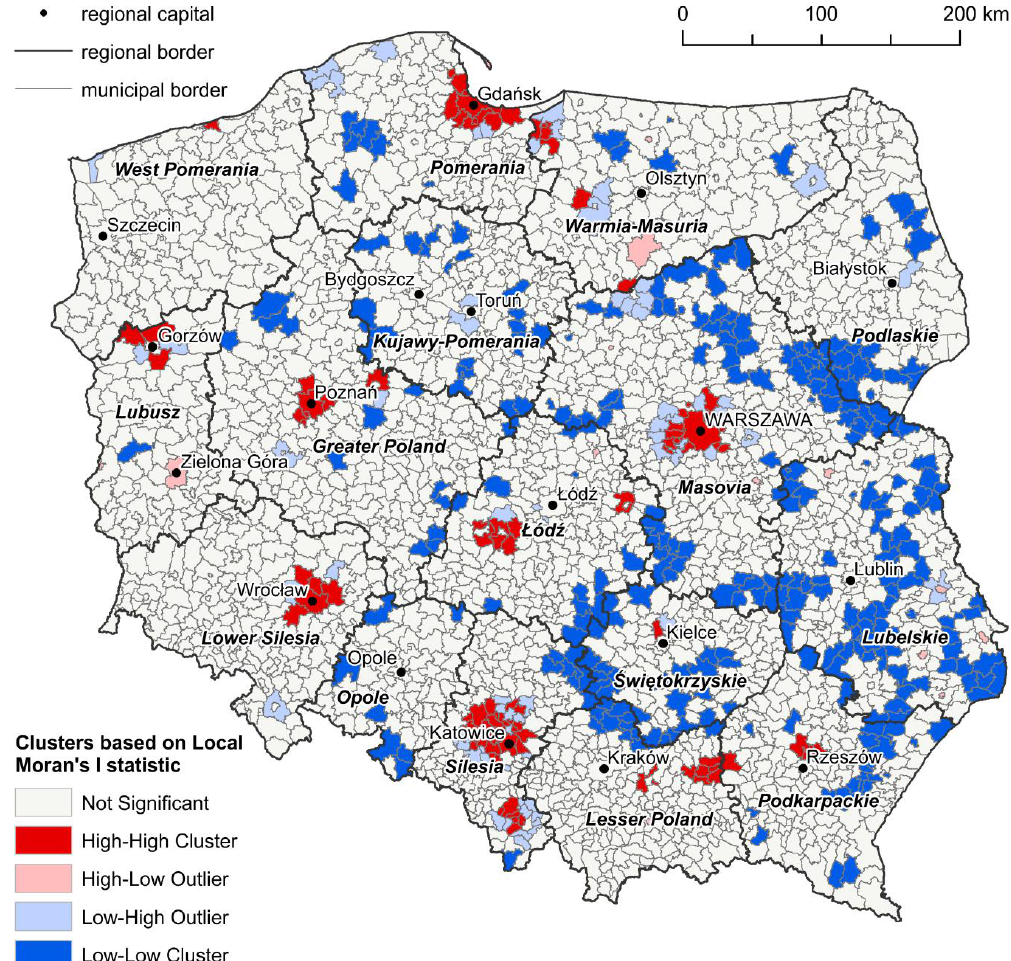
Figure 3. Hot spots and cold spots of spatial distribution of EU support under the Operational Program “Infrastructure and Environment” per square km in Poland, in the years